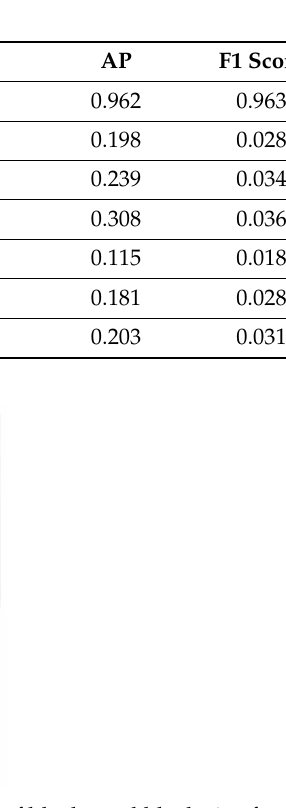
Figure 5. An illustration of the results for changing the number of blocks and block size for scale factor 16. Table 4. The impact of the total residual block and block size on vehicle detection of EDSR-RFA with a scale factor of 16. For RFA-16, the block size is 64 × 64, while the block size for RFA-32 is 128 × 128.